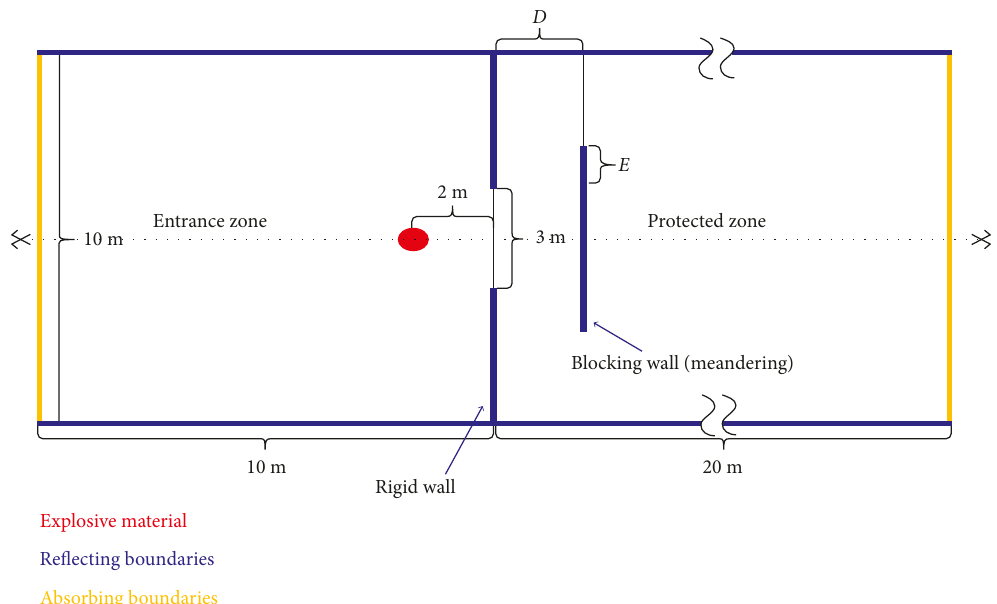
Figure 6: Geometry of the case study